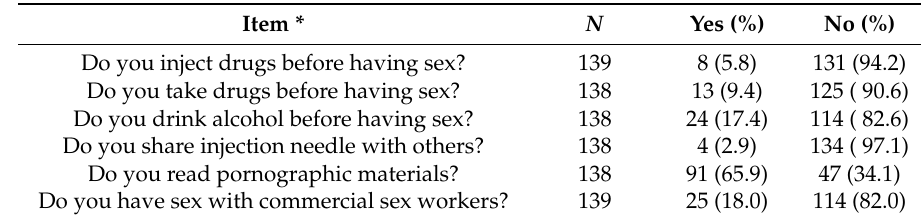
Table 4. Risky behaviors among the sexually-active university